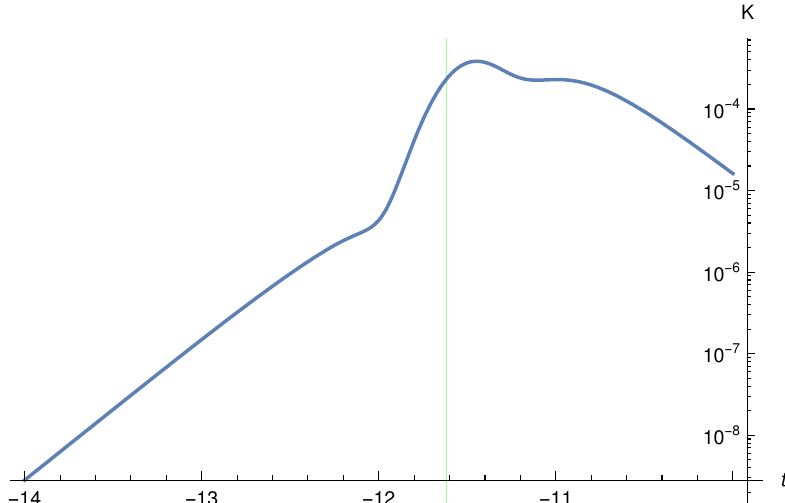
Figure 13. The Kretschmann scalar for the case α 1 (cid:54) = 0 with Ω c > 0. In particular, the parameters are chosen as m = 10 6 , ( ω cc , ω cb , Ω c ) = ( δ c given by Equation